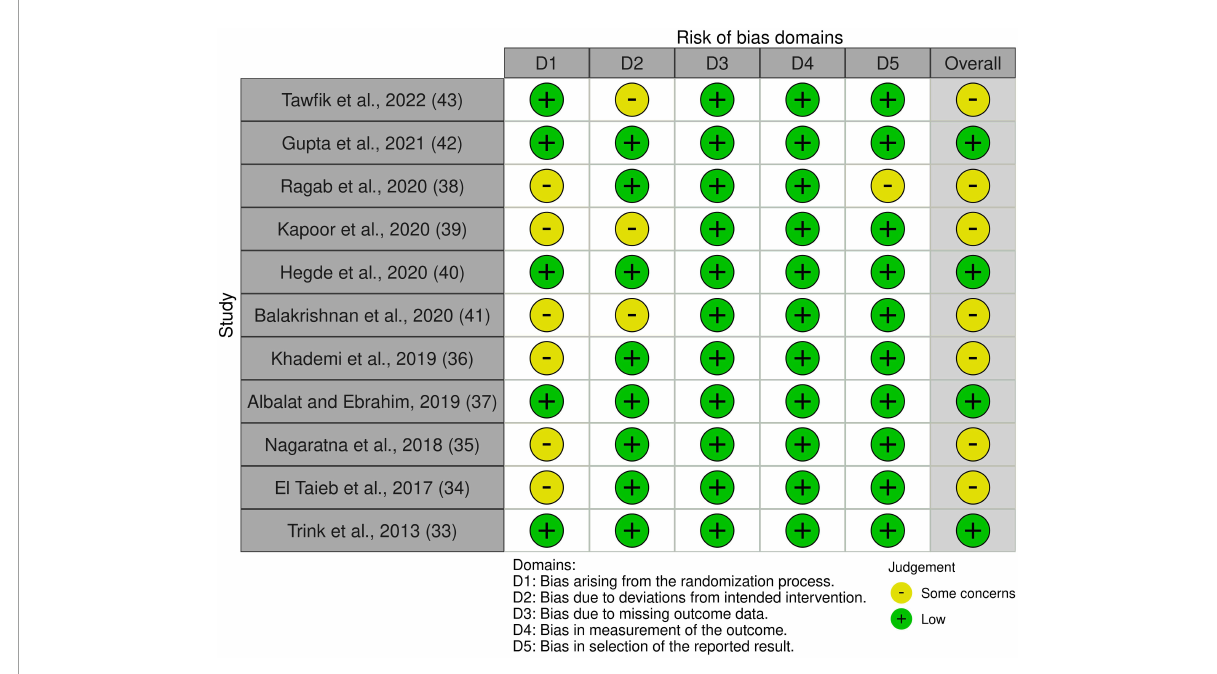
FIGURE2 Risk of bias of included non-randomized